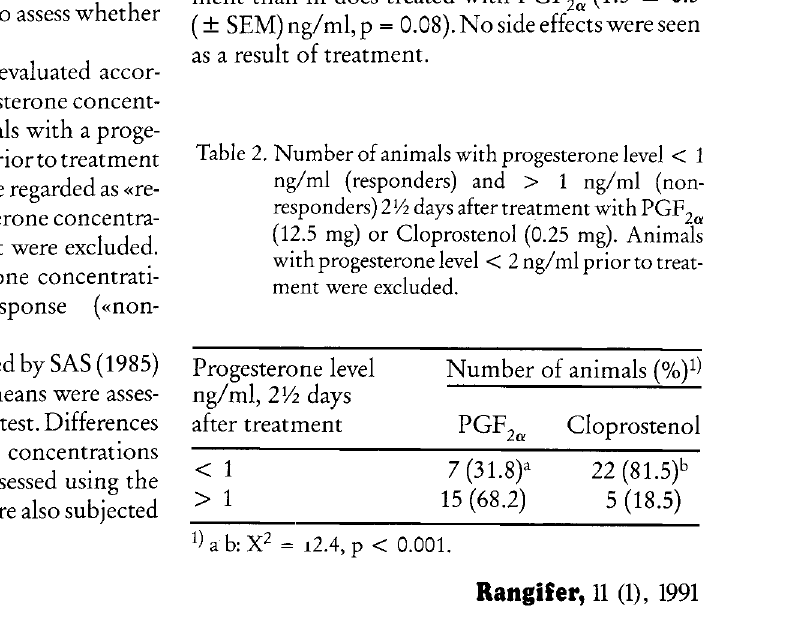
Table 2. Number of animals with progesterone level < 1 ng/ml (responders) and > 1 ng/ml